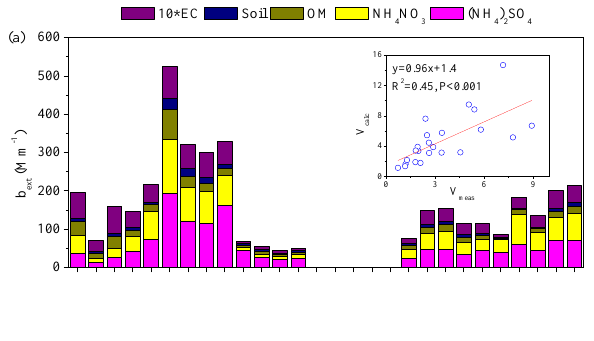
Figure 9. Source contributions to atmospheric PM 2 . 5 before, dur- ing, after the 2014 Spring Festival (SF) and the whole period by principal component analysis. pre-SF indicated the period before SF, covering the days from 24 to 29 January; SF indicated the pe- riod during SF, covering the days from 30 January to 6 February; after-SF indicated the period after SF, covering the days from 12 to 21 February. The whole period included pre-SF, SF and after-SF